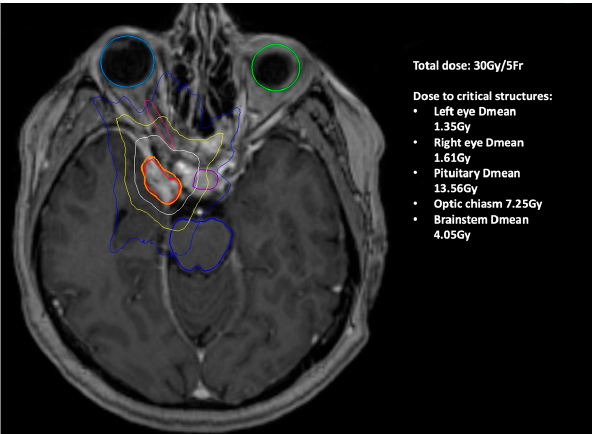
Figure 4. Illustration of the irradiated SRS field (Patient 1). The colored circles show isodose - areas with the same dose of radiation (orange is the planned dose of 30Gy, red is the maximum dose, white is 20 Gy dose area, yellow 10Gy, blue 5Gy). Light blue circle shows the right eye, green the left. The pituitary gland is shown in purple and the brain stem in blue.